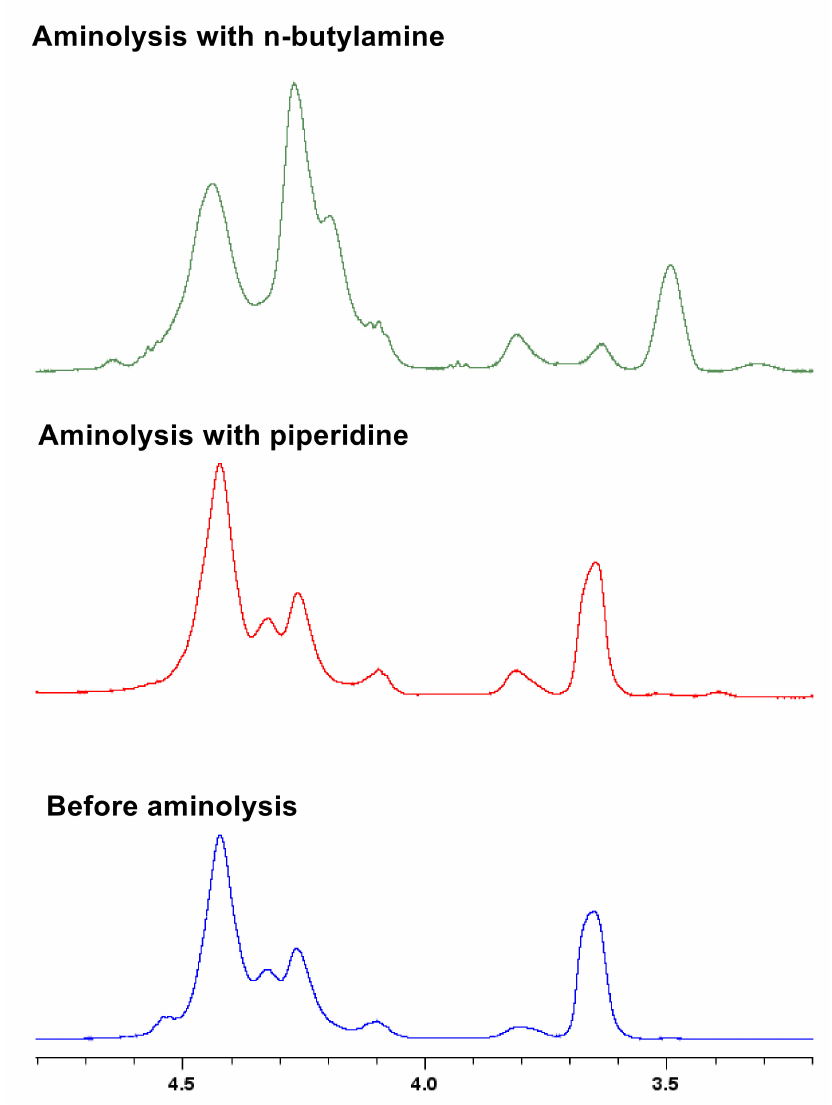
Figure 11. Comparison of 1 H-NMR spectra (400 MHz, acetone-d 6 ) of P(AAEM- co -FDA) before and after aminolysis using n-butylamine and